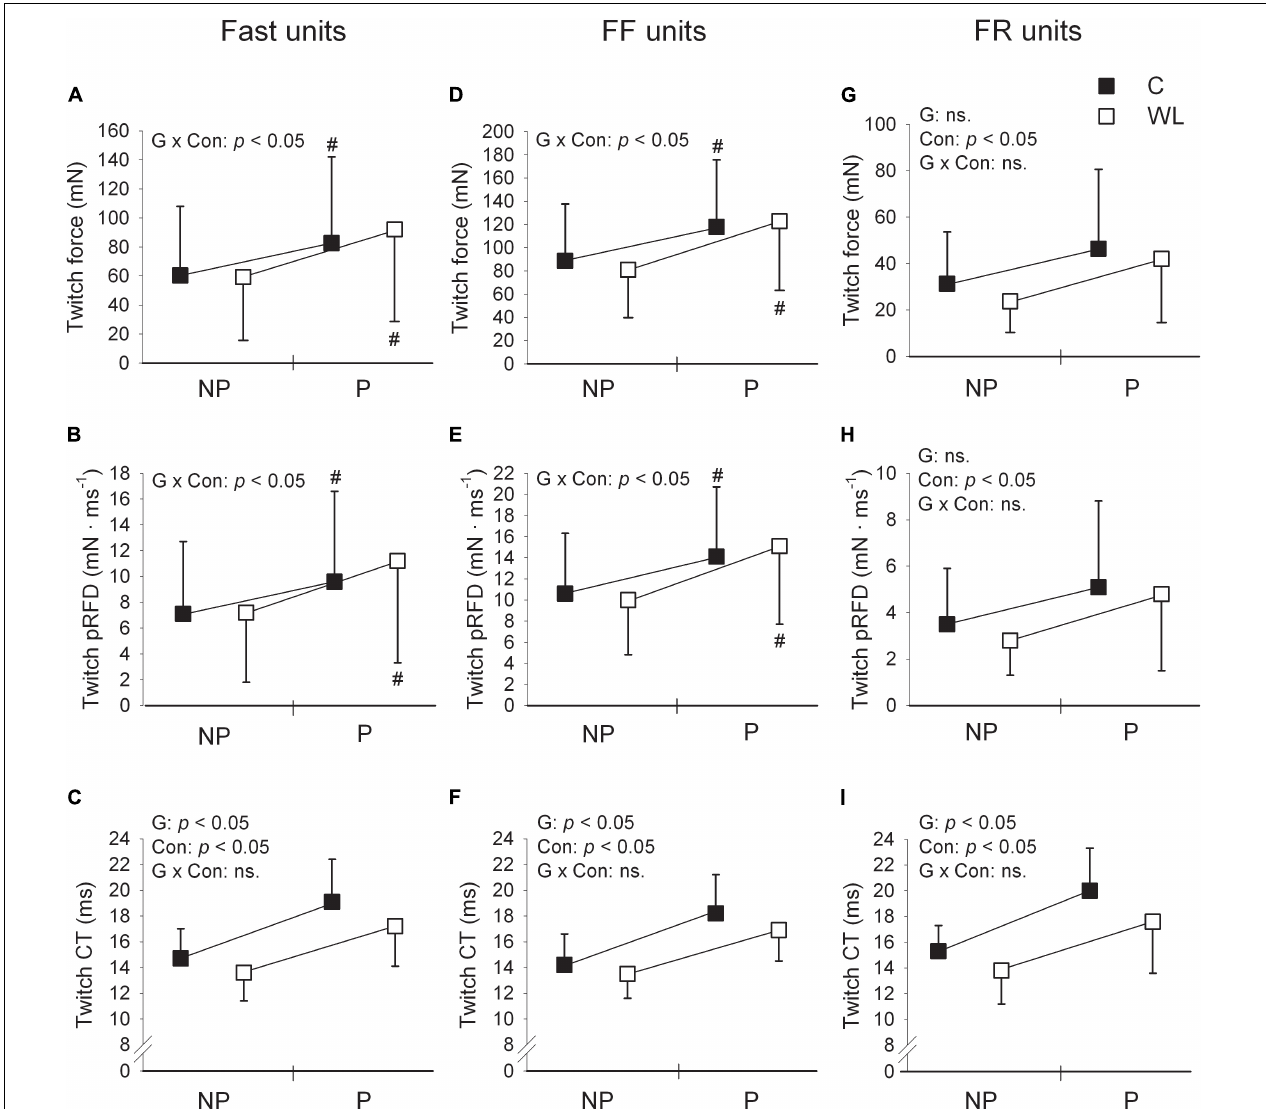
FIGURE 2 | Comparison of fast (A–C) , FF (D–F) , and FR (G–I) motor units’ contractile parameters for pre and post tetanic conditioning stimulation measurements in control (C) and weight-lifting trained (WL) animals. Data are presented as mean values and standard deviations. FF, fast fatigable; FR, fast fatigue resistant; pRFD, peak rate of force development; CT, contraction time; NP, non-potentiated; P, potentiated. The impact of factors G, group (control vs. weight lifting); Con, contraction (twitch non-potentiated vs. potentiated state); and G × Con, interaction between the group and contraction were expressed as significant ( p < 0.05) or not significant (ns.) p values, presented within panels. Post hoc analysis results: # = significant difference between pre and post measurements. Non-potentiated twitch force and contraction time values are from the previous study (Łochy´nski et al., 2016) and are included for comparison. Note much substantial shortening of the contraction time of the potentiated twitch (much higher partial eta squared values for the ANOVA’s effect of group, Table 2 ) in FR [ (I) , large effect size] than FF [ (F) , small effect size] motor units. In addition, when control and weight-lifting rats were analyzed with two-sided post hoc comparisons, effect sizes expressing the magnitude of decrease in the contraction time of potentiated twitches were also higher in FR (Cohen’s d = 0.65) than FF (Cohen’s d = 0.48) motor units. These observations coincided with increased potentiation of twitch force and pRFD in FF (D,E) but not FR (G,H) motor